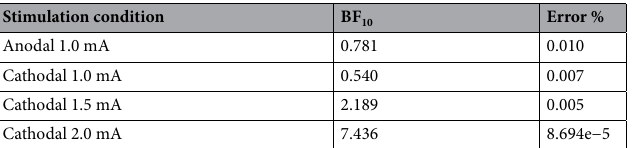
Table 1. Individual BF 10 and percent error for each stimulation condition (as compared to sham) for average task-unrelated thought across all experimental trials for Filmer et al. 4